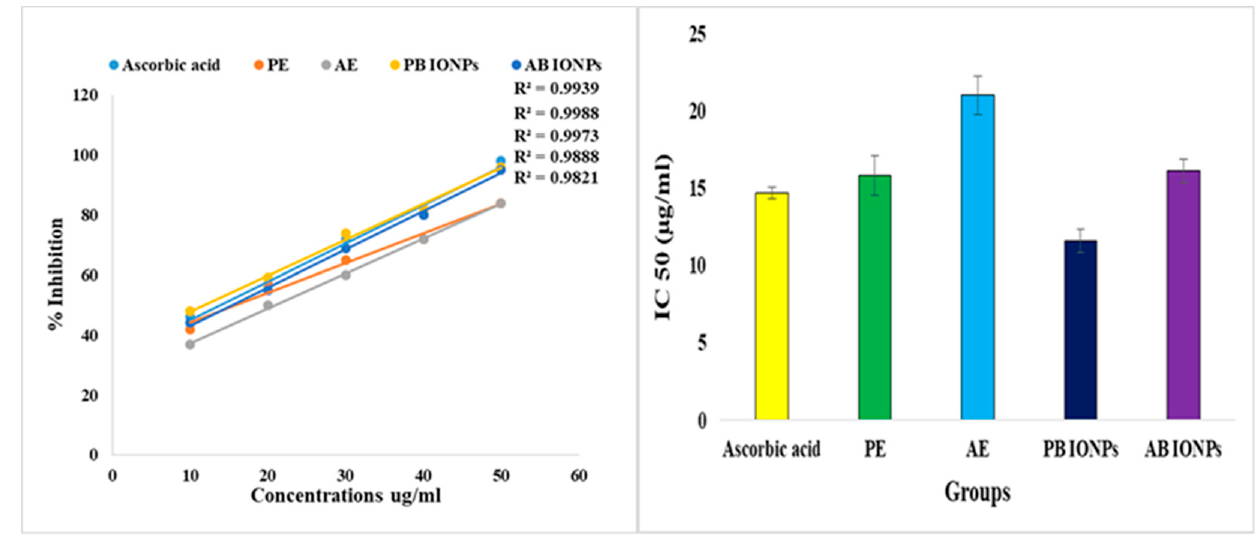
Figure 9. Antioxidant activity of AE, PE, and algal- and plant-based Fe 3 O 4 NPs and the concentration needed to inhibit 50% of the scavenging activity of DPPH.